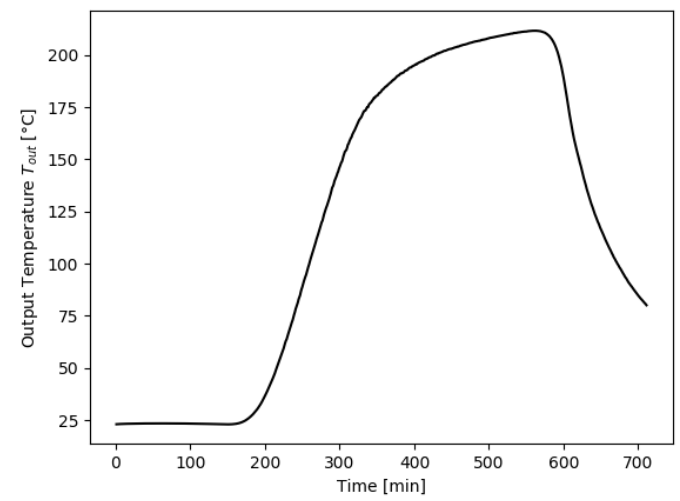
Figure 11. Results of the Simulation Service for the output temperature T out of the Packed-Bed Thermal Energy Storage (PBTES) for a specific load